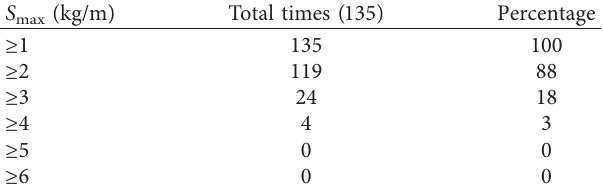
Figure 9: Distribution of range of gas desorption index K drilling cuttings predicted during field testing. Table 13: Distribution of percentages of the index S of weight of drilling cuttings predicted during field